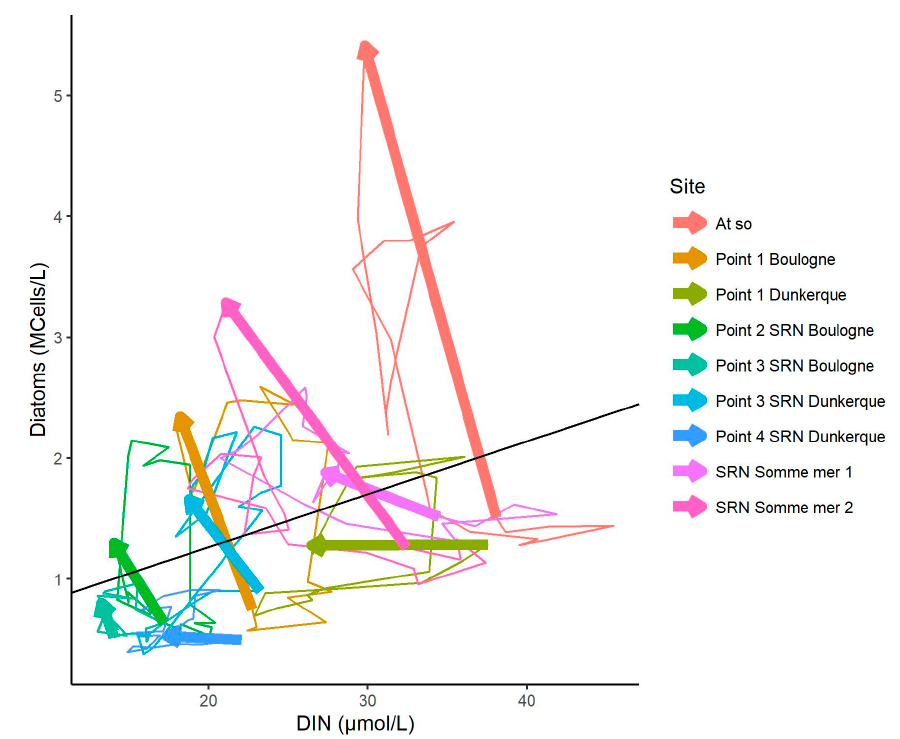
Figure 12. Temporal trajectories of the relationship between diatoms and Dissolved Inorganic Nitrogen (DIN) concentrations by site and by period (six-year sliding periods between 1994 and 2018). The arrows indicate the overall trajectories (first period to last period). Complete trajectories are represented by thin colored lines. J. Mar. Sci. Eng. 2019 , 7 , x FOR PEER REVIEW